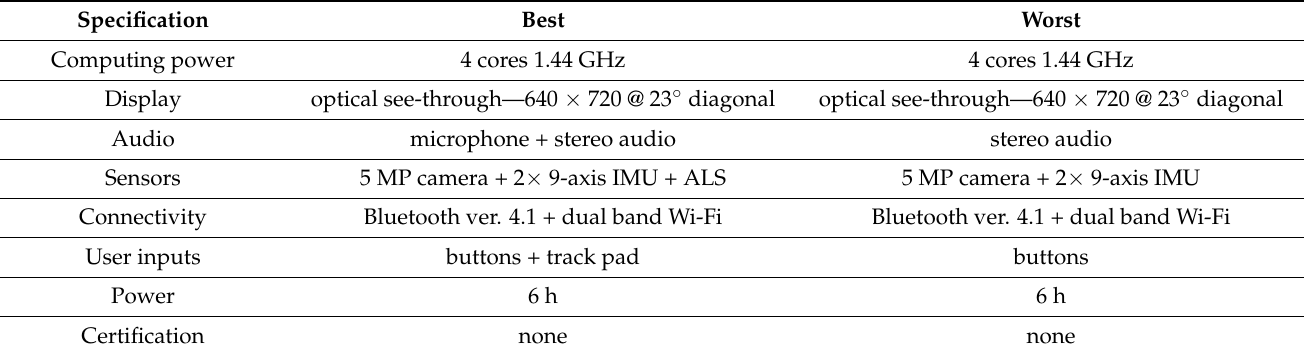
Table 5. Entertainment HMD specifications.